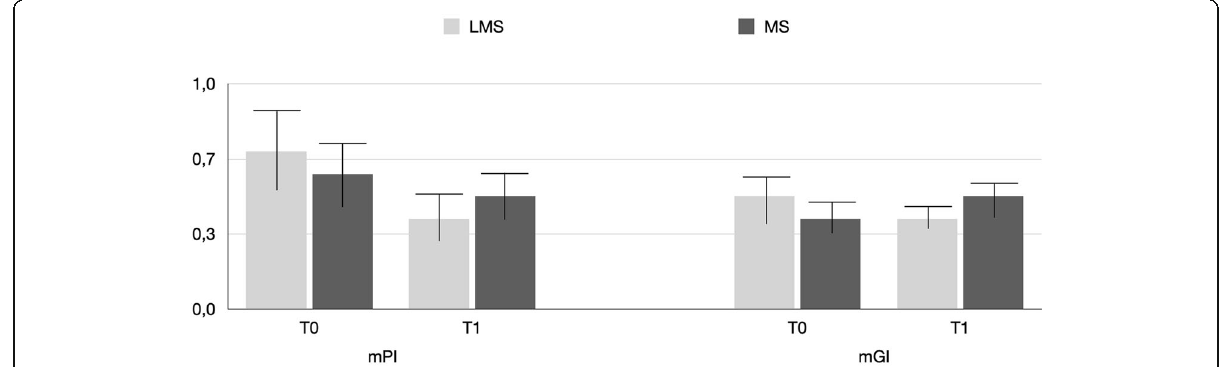
Fig. 2 Mean mPI and mGI values recorded around LMS and MS abutments during the study